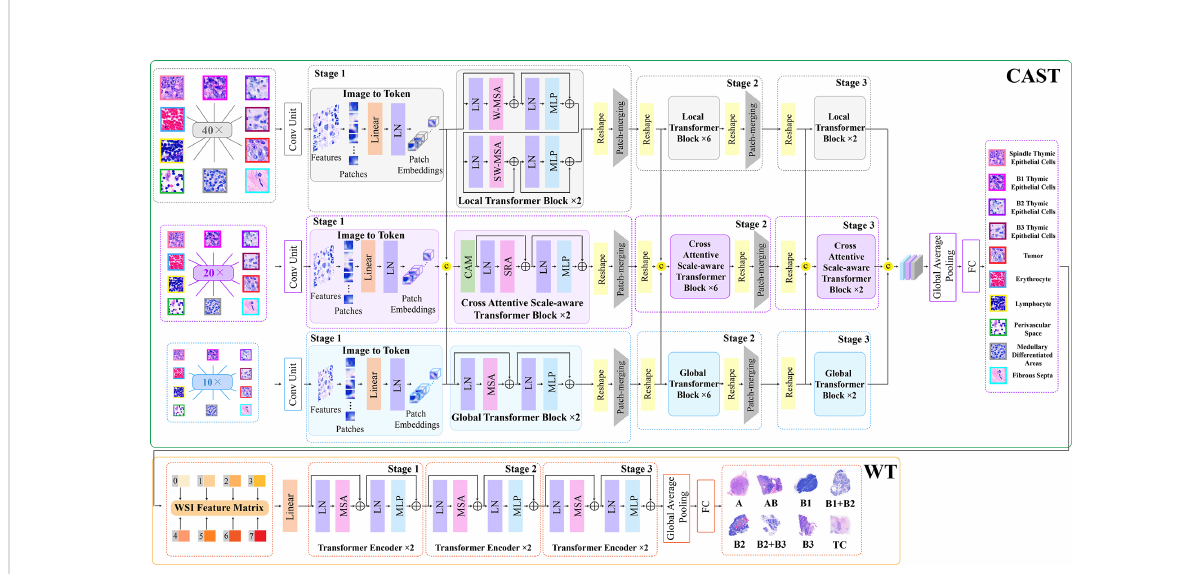
FIGURE 3 The architecture of the proposed multi-path cross-scale vision transformer (MC-ViT), which consists of the cross attentive scale-aware transformer (CAST) for pathological information classi fi cation and the WSIs transformer (WT) for thymoma